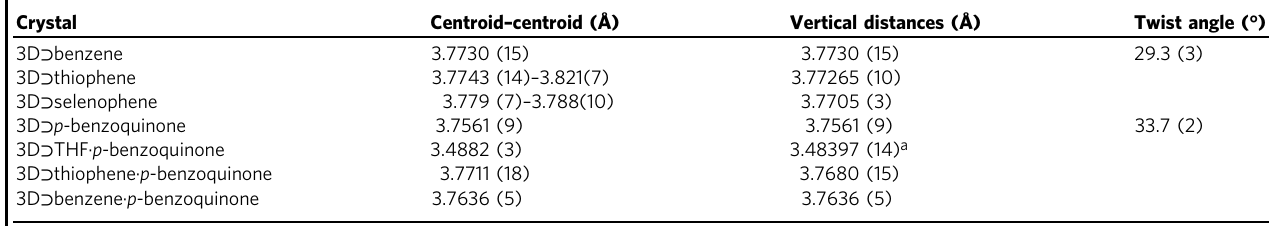
Table 1 Distances and twist angle between two adjacent guest molecules in 3D ⊃ guest